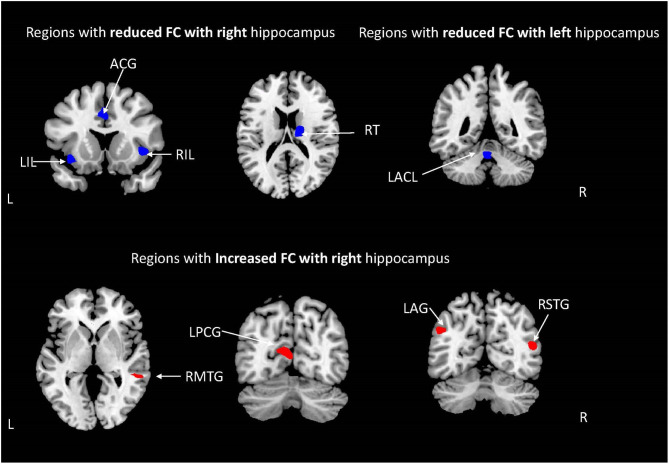
The brain regions with abnormal hippocampal functional connectivity (FC) in patients with moderate to severe obstructive sleep apnea [weakened FC (blue), enhanced FC (red); AlphaSim corrected; P < 0.001; cluster volume > 10 voxels].